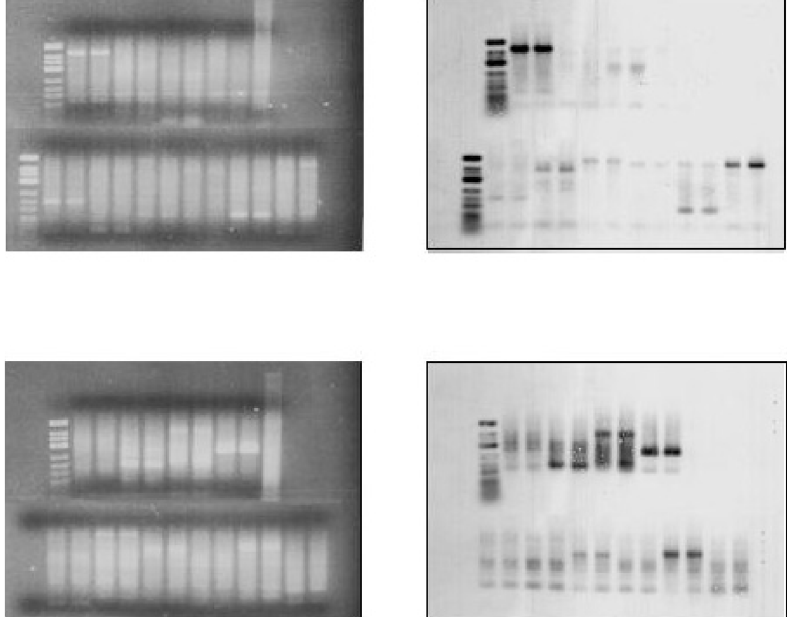
Figure 6. Evidence for homology between first PCR AFLP products amplified with di ff erent oligonucleotide primers. PCR was performed on replicate DNA templates of sugarcane hybrid 79A362 ((a) and (b)) and the nod49 mutant soybean cv. Bragg ((c) and (d)). The Eco RI oligonucleotide primer E36 with three additional 3 (cid:3) nucleotides (5 (cid:3) -GACTGCGTACCAATTCACC-3 (cid:3) ) was used in the first PCR with a range of Mse I primers, each with a di ff erent combination of three additional 3 (cid:3) nucleotides. The three additional 3 (cid:3) nucleotides on the Mse I primers were as follows: lanes 1, ACA; lanes 2, ACC; lanes 3, ACG; lanes 4, ACT; lanes 6, AAA, lanes 7, AGA; lanes 8, ATA; lanes 9, CCA; lanes 10, GCA; and lanes 11, TCA. Lane 5 contained 500ng of genomic DNA digested with Mse I. The reactions were separated on 2% agarose gels ((a) and (c)) and blotted onto nylon membranes. A radioactive probe corresponding to the PCR